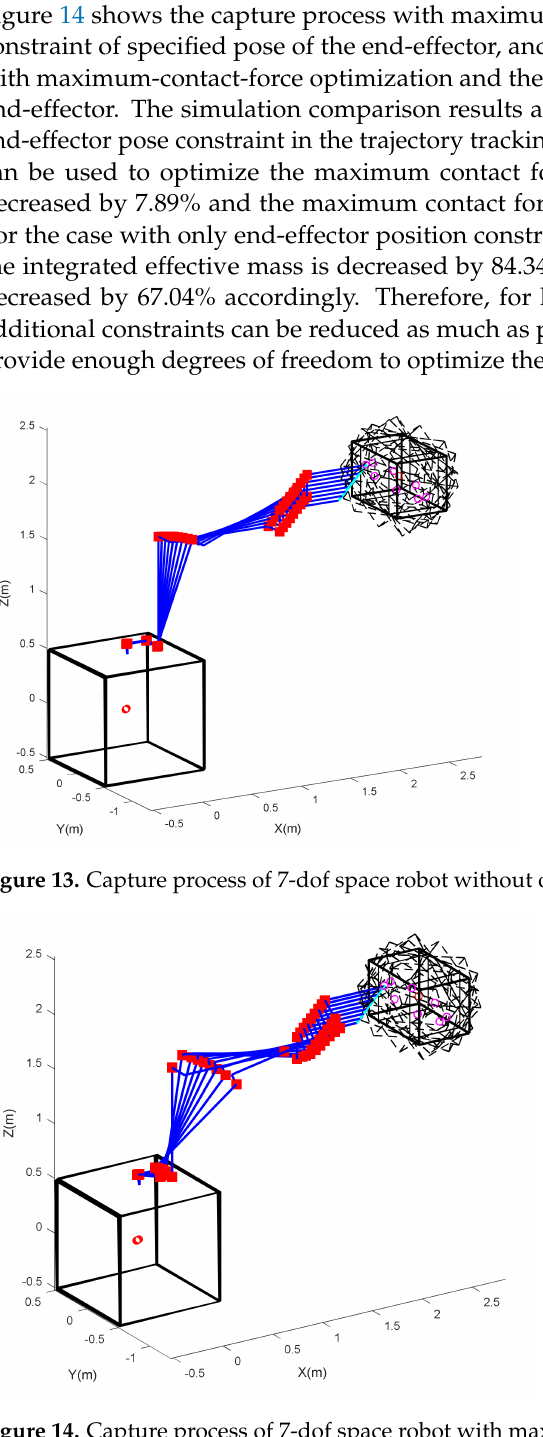
Figure 14. Capture process of 7-dof space robot with maximum-contact-force optimization and the constraint of specified pose of the